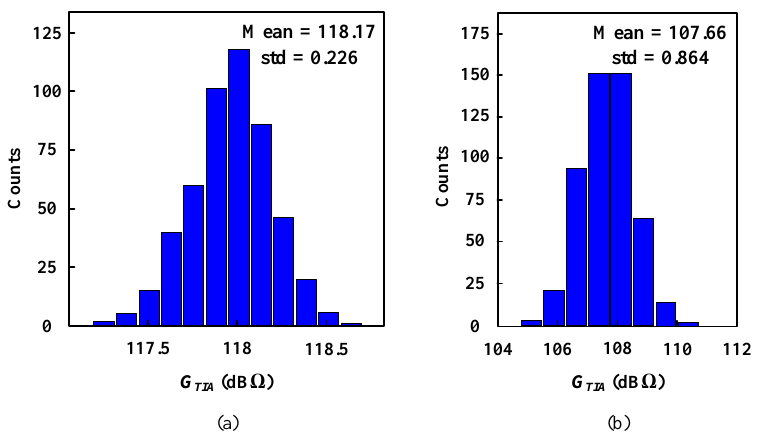
Figure 7. Monte-Carlo histograms of the proposed TIA (N = 500): ( a ) G TIA − Max = 118.2 dB Ω and ( b ) G TIA − Min = 107.6 dB Ω .